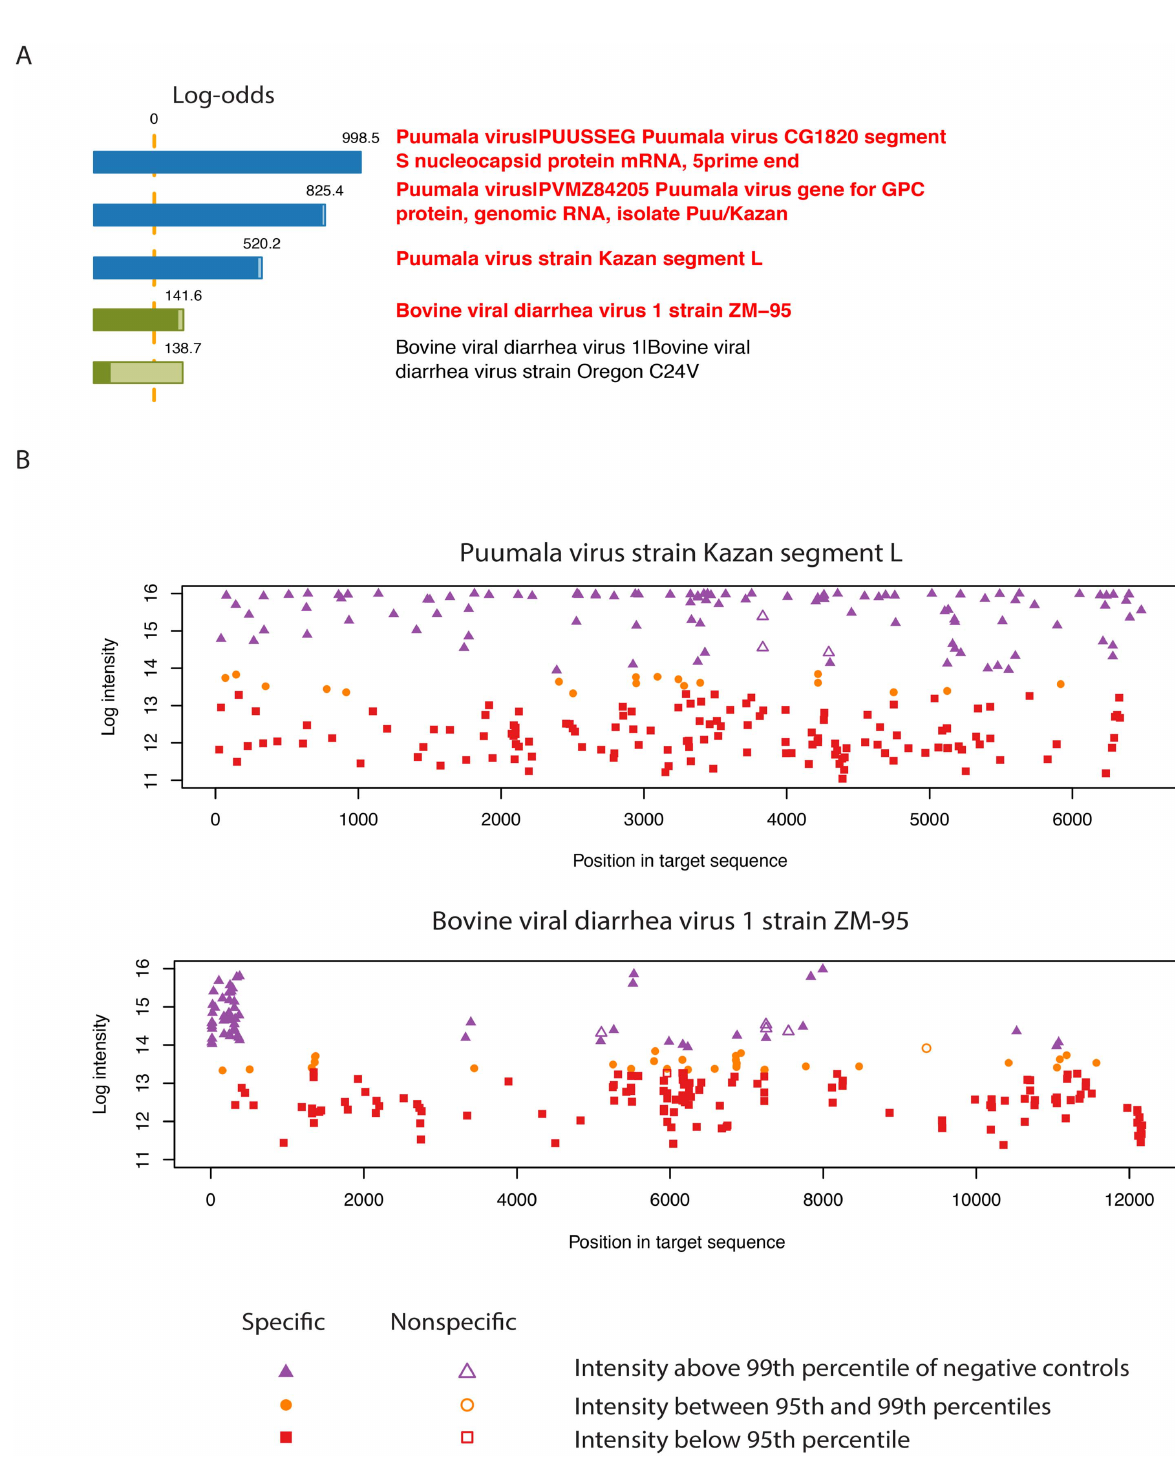
Figure 3. CLiMax analysis detects Puumala virus in a non-clinical sample. The results of microarray analyses of WT-amplified viral DNA- samples, using CLiMax analysis. (A) Log-odds scores for a Puumala virus-positive sample. The lighter and darker-coloured portions of the bars represent the unconditional and conditional log-odds scores, respectively. The conditional log-odds scores shows the contribution from a target that cannot be explained by another, more likely target above it, while the unconditional score illustrates that some very similar targets share a number of probes. (B) Target sequence-probe alignment plots for segment L of the Puumala virus genome and for BVDV-1, showing probe intensity vs probe position in the viral genome. Plot symbol and color indicates positive ( . 99 th percentile), negative ( , 95 th percentile), or equivocal hybridisation signals; hollow symbols indicate probes found to hybridise non-specifically. The pattern seen for BVDV-1, in which positive probes are restricted to a few narrow genome regions, is a typical cross-hybridisation result.